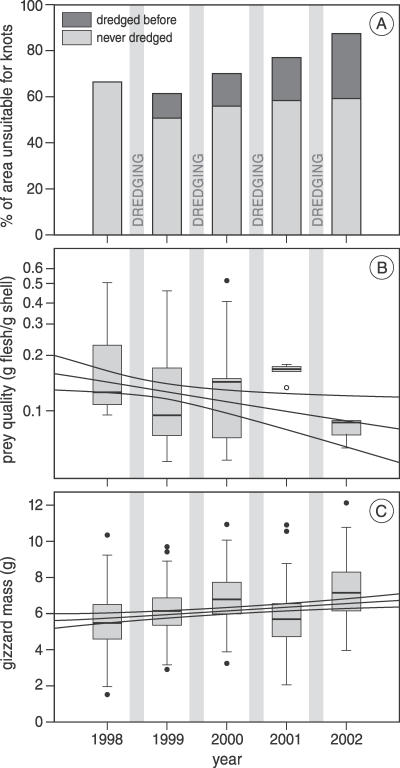
Changes in Suitability, Prey Quality, and Gizzard Mass(A) The percentage of blocks that yielded insufficient intake rates (<4.8 W) increased over time due to an increase in unsuitable blocks being dredged in previous years (dark gray bars; as opposed to light gray bars indicating unsuitable blocks that were never dredged).(B) Quality of prey included in the diet has declined over time (box-and-whisker plot, line gives GLM ± 95% confidence intervals).(C) In response, gizzard mass has increased over time (boxes and lines as in (B)).